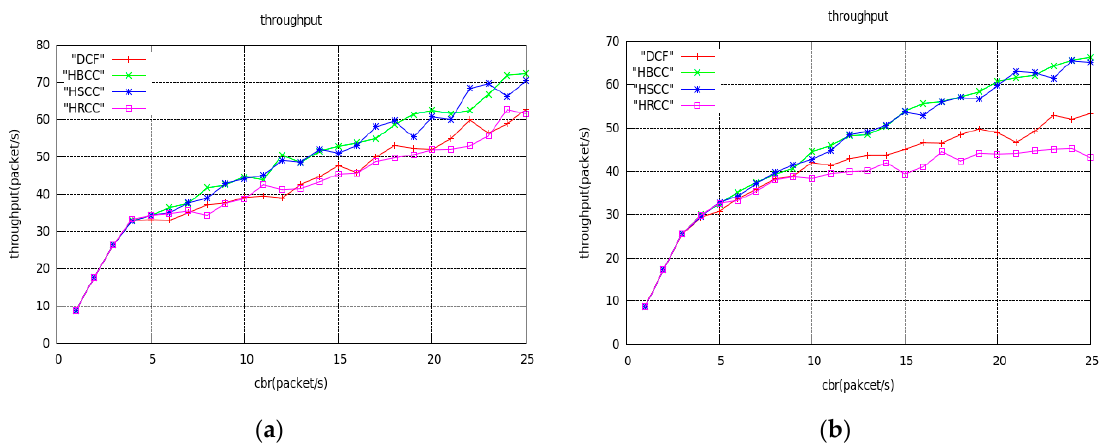
Figure 15. Average throughput curves of random network topology. ( a ) The topology of Figure 14a; ( b ) The topology of Figure 14b.